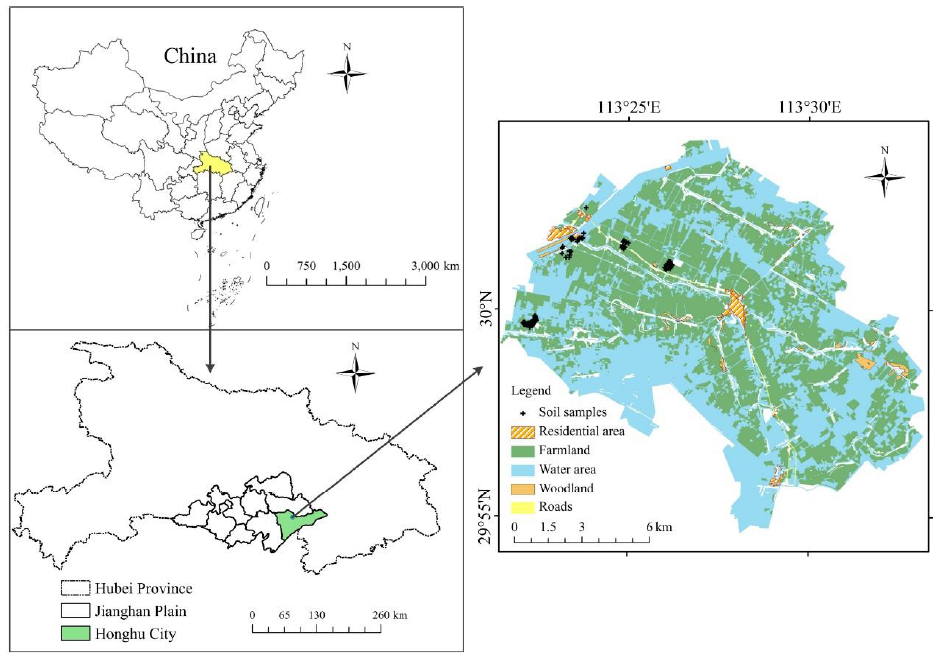
Figure 1. Study area and soil sampling locations.